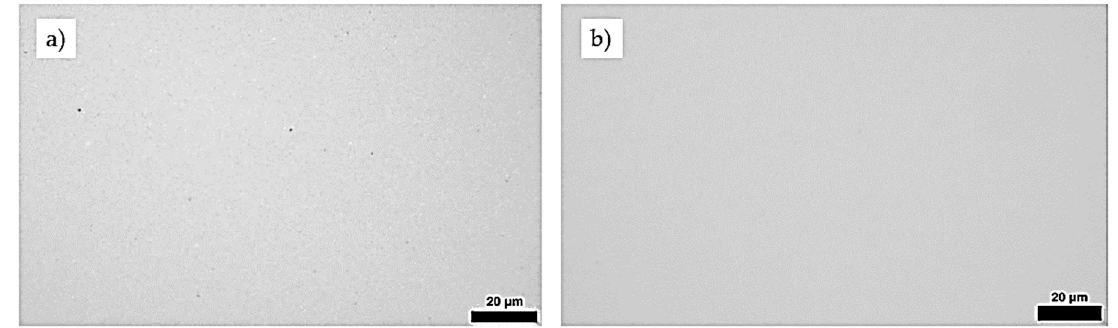
Figure 14. Optical micrograph of polished surface of the substrates, 500 × magnification: ( a ) SH-5; ( b ) SH-15.